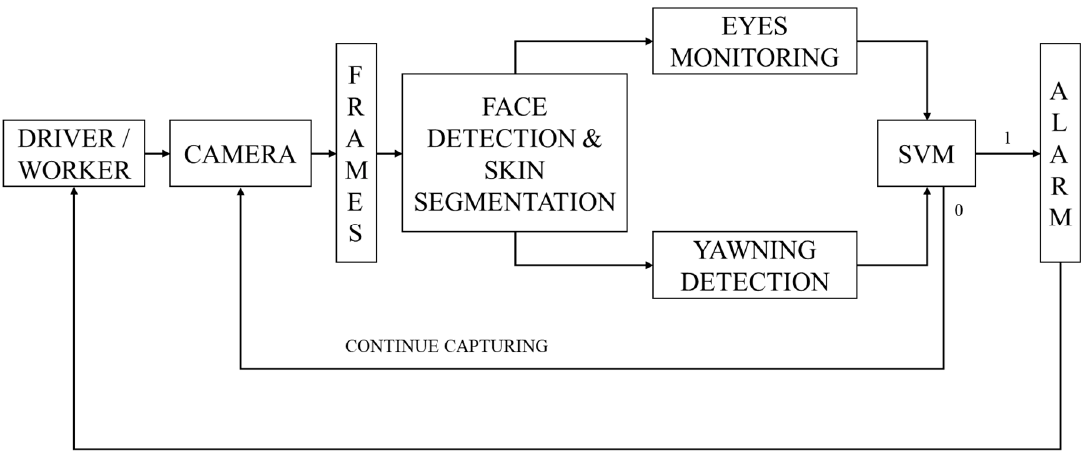
Figure 2. Logical framework of the proposed approach.